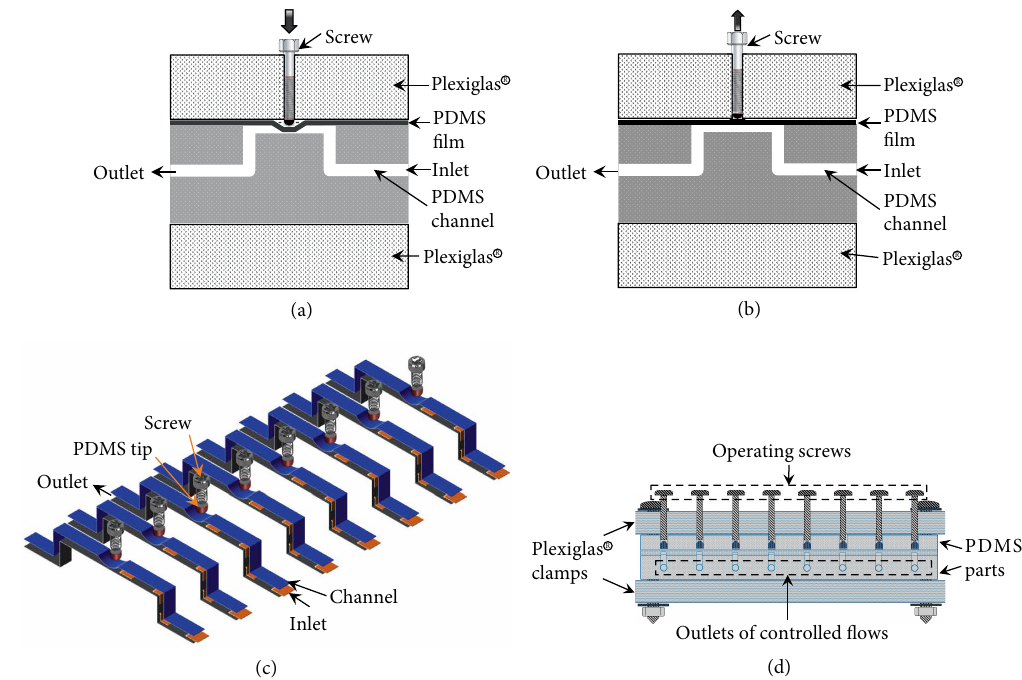
Figure 1: Design of the multi-valve system for controlling the inlet flows into microfluidic system. (a) and (b) The cross sections of valves switch (at one flow controlling); (c) and (d) the multi-flow controlling arrangement and construction.